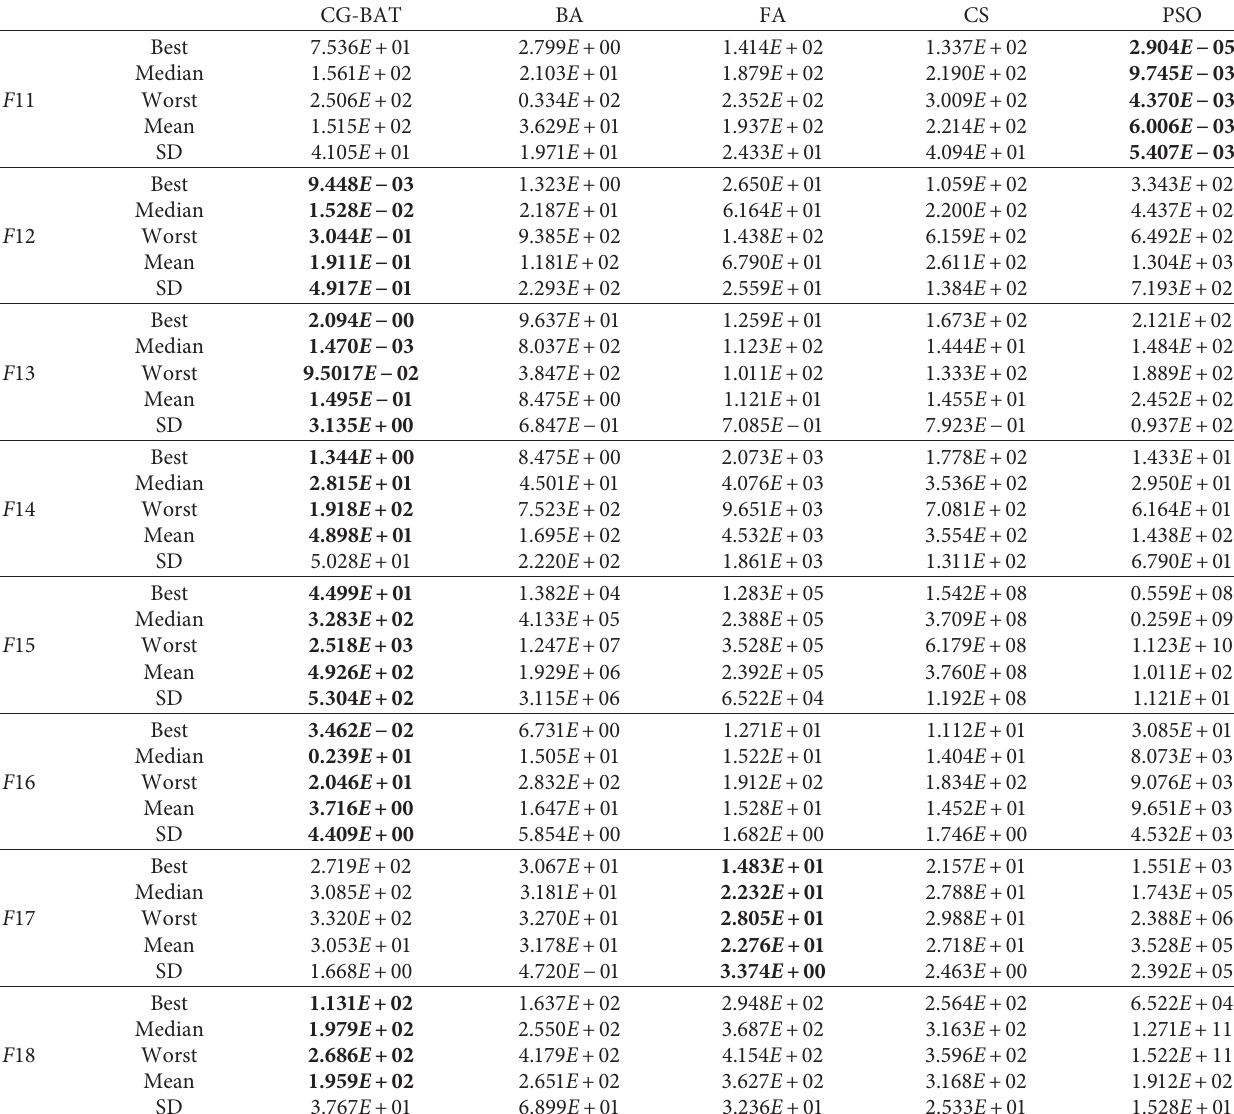
Table 3: Comparison between CG-BAT and classical algorithm on benchmark functions ( F 11 ∼ F